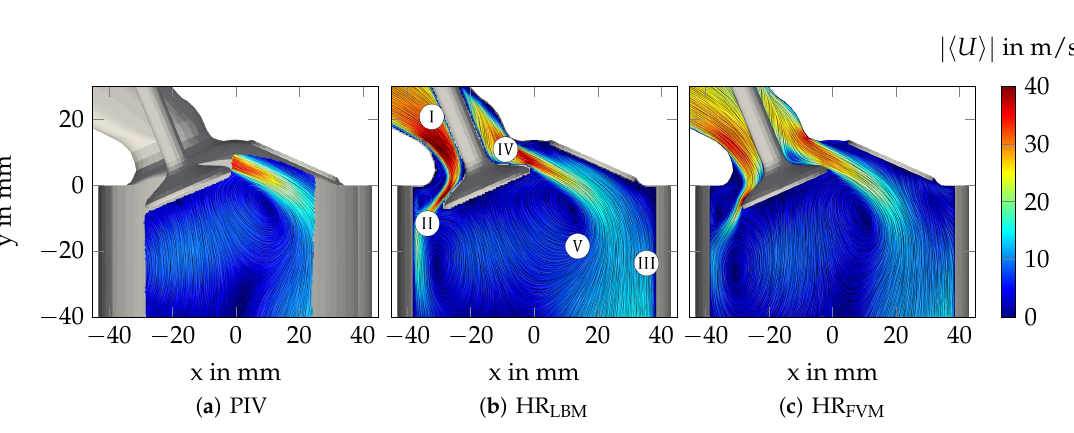
Figure 6. Line integral convolution visualization of the averaged velocity field with local characteristic flow patterns (I-V) of the PIV measurements ( a ), along with the OpenLB ( b ) and OpenFOAM ( c ) numerical